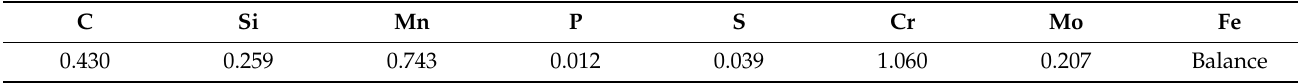
Table 1. Chemical composition of the test material in